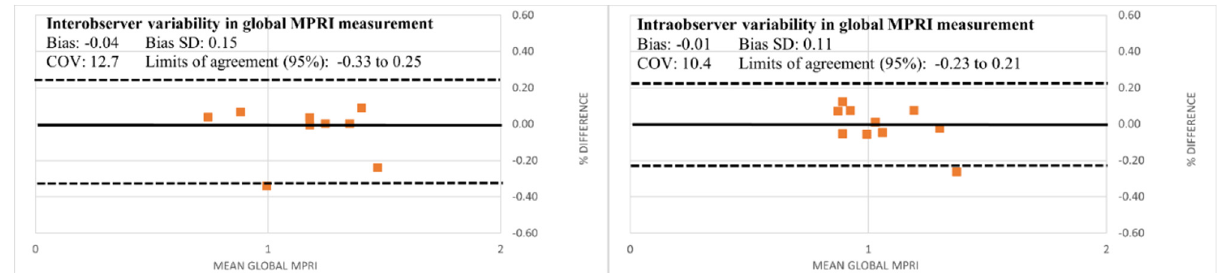
Figure 5. Bland–Altman plots for intraobserver and interobserver variability in measuring the mean global MPRI, with coefficient of variation (COV), bias and limits of agreement.